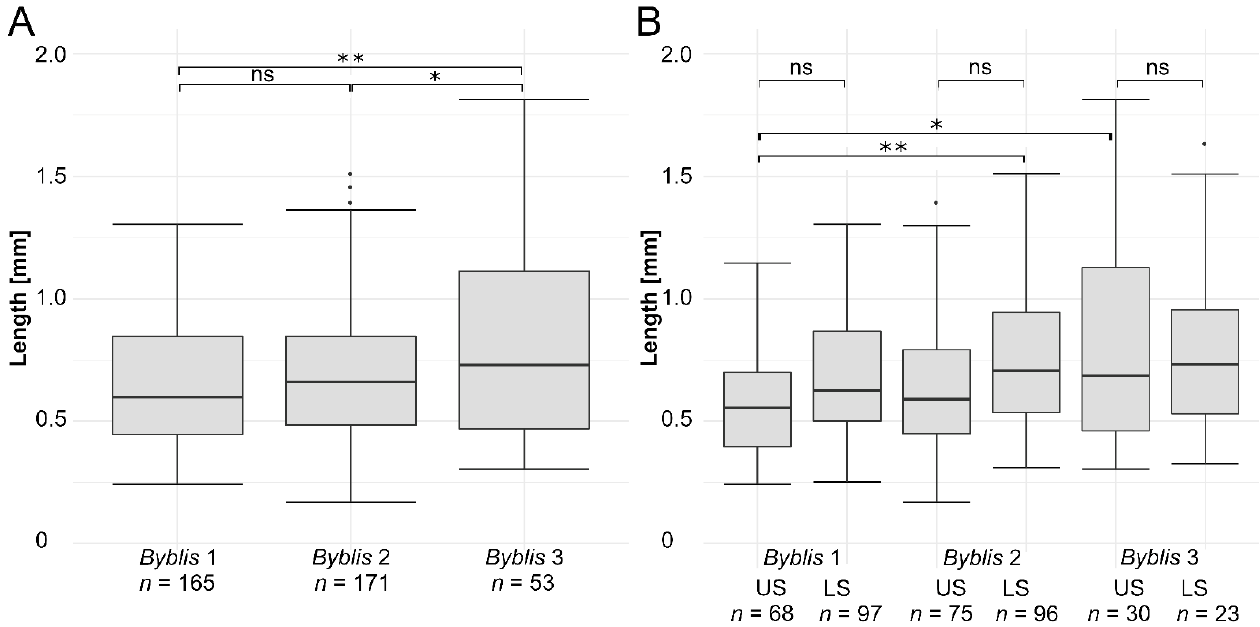
Figure 2. Stalked gland lengths measured on three leaves from three B. gigantea plants ( Byblis -1, Byblis -2, Byblis -3) and grouped according to the respective plants in ( A ) and according to the respective plants and positions on the leaves (upper and lower surfaces) in ( B ). The asterisks indicate the significance levels ( * 0.01 ≤ p < 0.05; ** ≙ 0.001 ≤ p < 0.01; ns ≙ not significant). The sample sizes ( n ) are indicated. US = upper surface of the respective leaf; LS = lower surface. For clarity, the non-significant results only, between the upper and lower surfaces of the individual leaves, are indicated in ( B ).